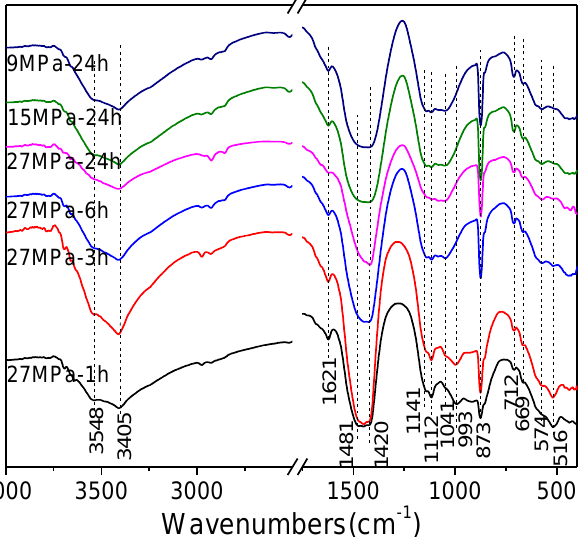
Figure 9. FTIR analyses of the samples with different molding pressures and curing times.